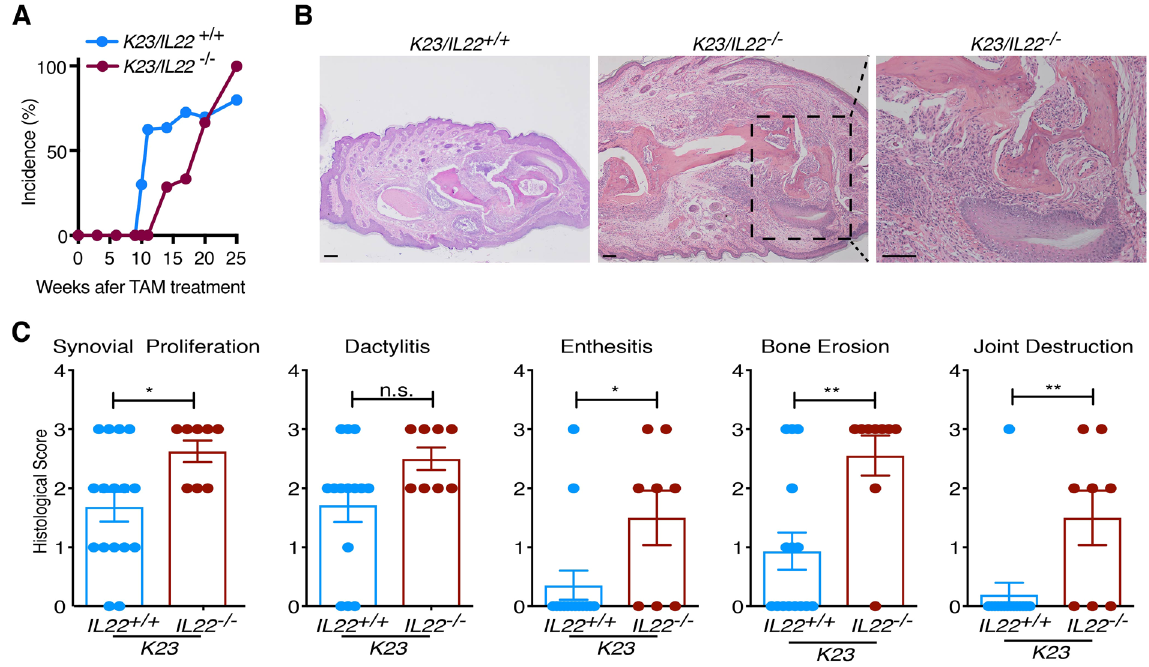
Figure 8. IL-22 deficiency aggravates the PsA-like disease in K23 mice. ( A ) Incidence of disease in the paws of K23/IL22 + / + mice and K23/IL22 − / − mice after TAM treatment. ( B ) Lower paw histology of K23/IL22 + / + mice and K23/IL22 − / − mice 25 weeks after TAM treatment. Inset revealed erosive changes and destruction of the distal phalanx and adjacent joints (n = 8-9 mice/group). Scale bars, 100 μ m. ( C ) Histological scores of K23/ IL22 + / + mice and K23/IL22 − / − mice lower paws 25-30 weeks after TAM treatment. Data are shown as mean ± SEM, ns, p > 0.05, * p < 0.05, ** p < 0.01, by nonparametric Mann-Whitney